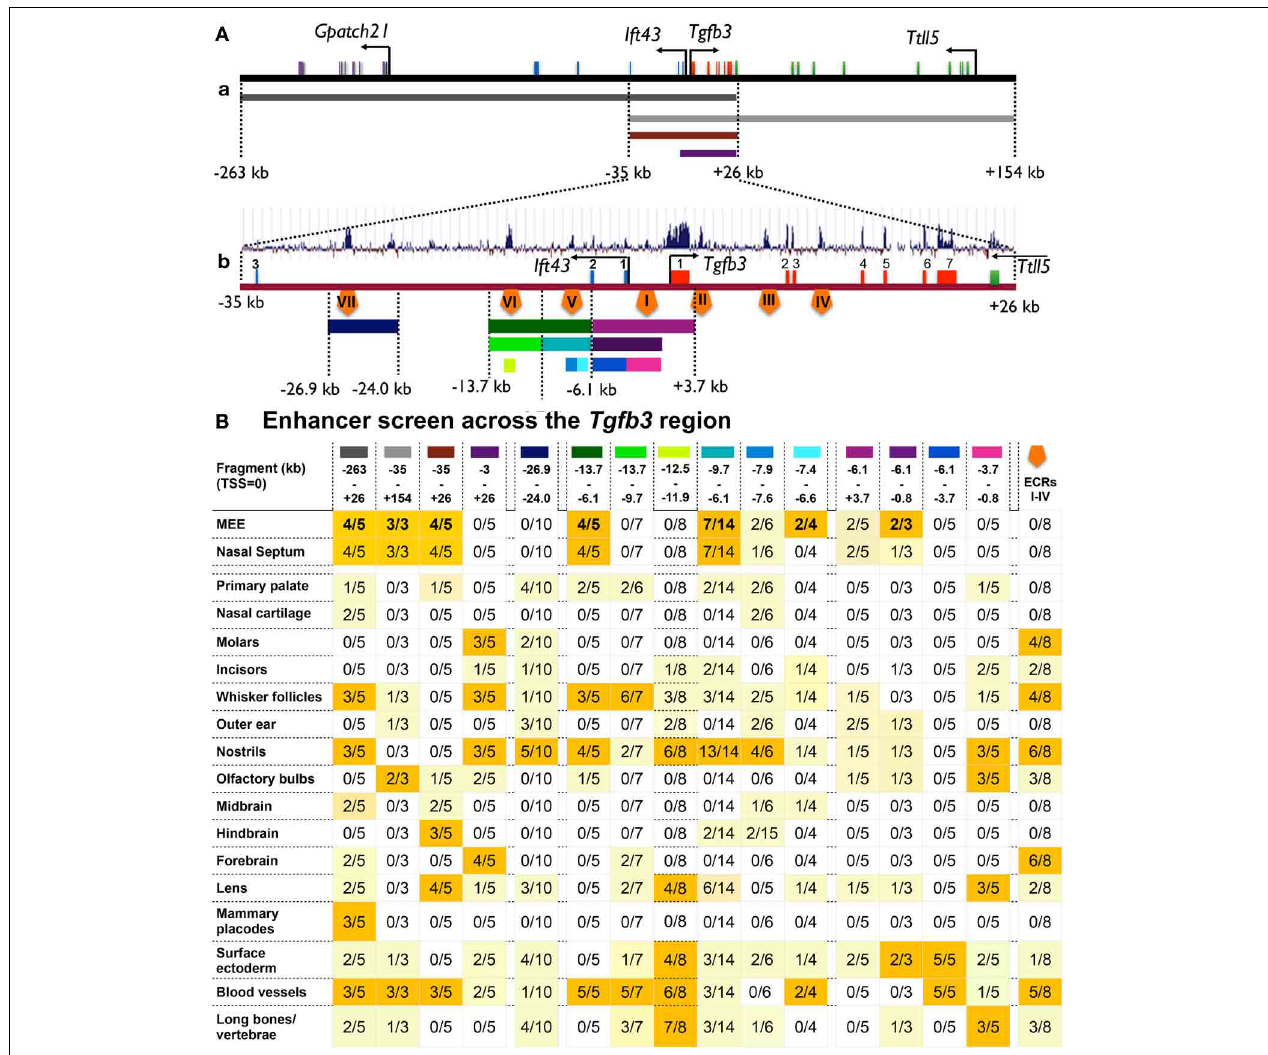
FIGURE 3 | Enhancer screening across the Tgfb3 region. (A) Schematic representation of the regions examined to locate cis-regulatory sequences directing reporter activity to the MEE/periderm cells. (a) 417-kb of genomic DNA (black line) including the Tgfb3 gene (red boxes represent exons); colored lines beneath correspond to the positions of BAC sequences used for expression regulation analysis (see B , first four columns). (b) Schematic representation of the 61-kb region in common between the 5 (cid:3) and 3 (cid:3) BACs (brown line) showing the Tgfb3 gene (exons in red), exons 1–3 of the Ift43 gene (blue boxes) and exon 16 of the Ttll5 gene (green box). Graph above shows evolutionary sequence conservation among placental mammals